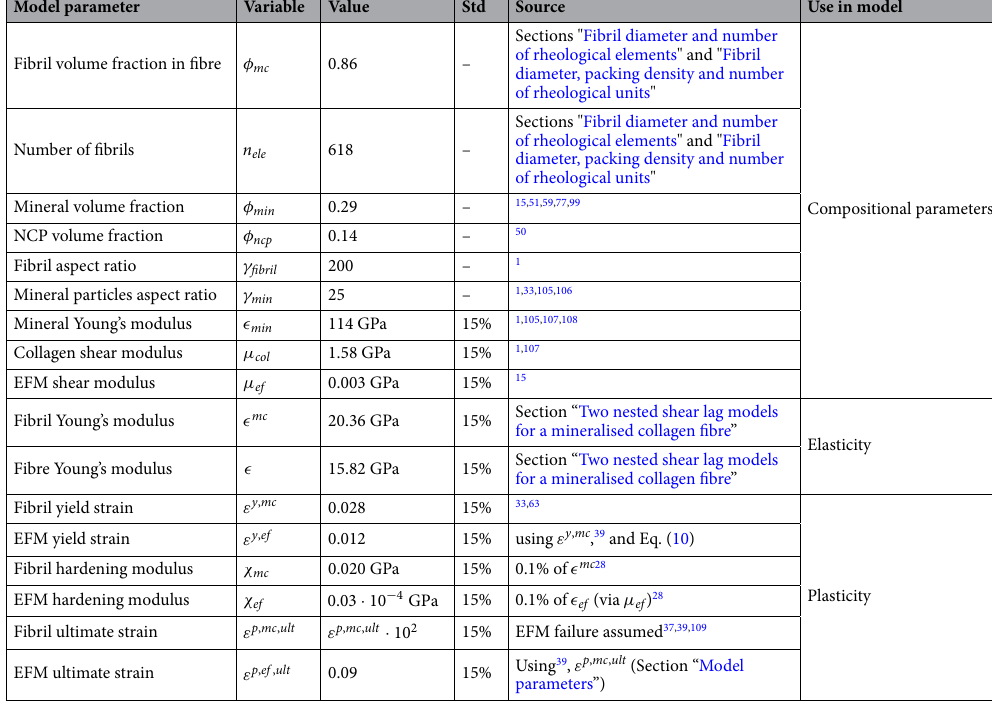
Table 2. Model parameters for a mineralised collagen fibre. The table lists the compositional parameters of the fibre (first section of the table) to calculate fibril and fibre elasticity (second section of the table) via two nested shear lag models. Plasticity calculations were done based on the elasto-plastic rheological elements (third section of the table). The number of rheological elements equals the number of fibrils. Own experimental values were taken where possible and referenced to the corresponding sections. Additional values were taken from the literature. Std: standard deviation for statistically distributed mechanical properties, NCP: non-collageneous proteins (includes the volume fraction occupied by water when the tissue is wet), EFM: extrafibrillar matrix, mc: mineral-collagen composite (= mineralised collagen fibril), ef: